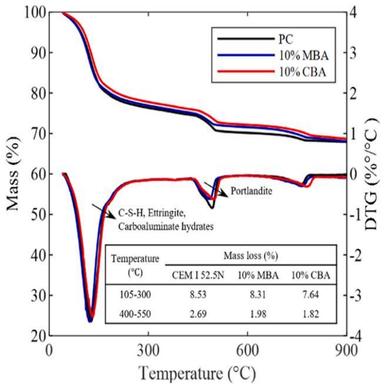
TG and DTG curves of trail mixtures at the age of 28 days.